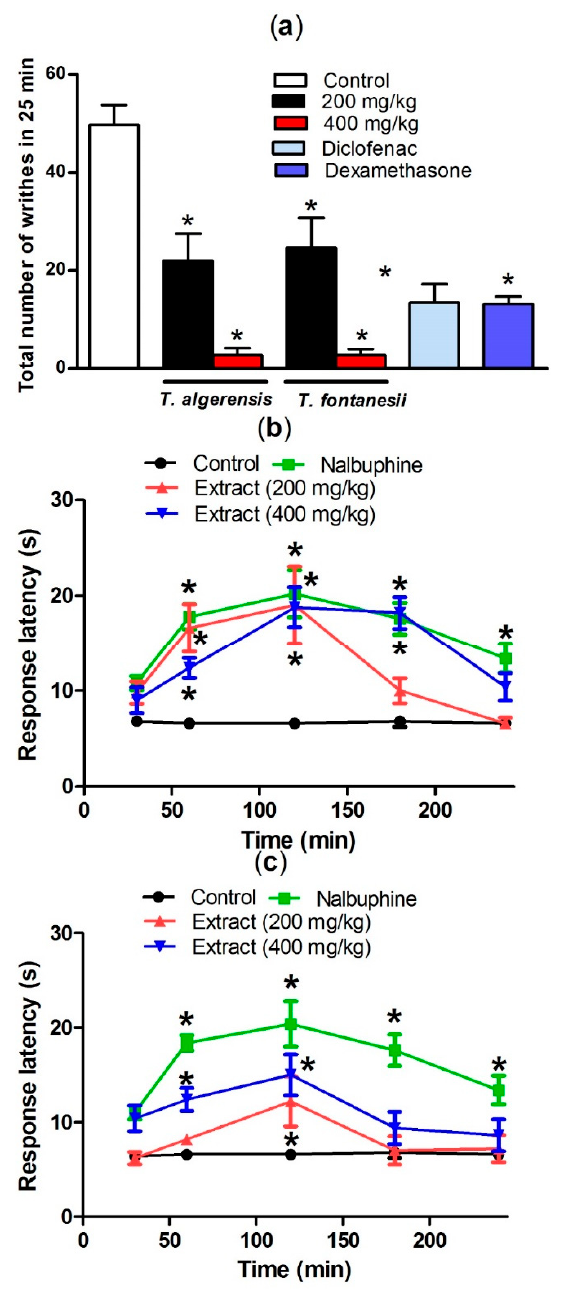
Figure 5. E ff ect of T. algeriensis or T. fontanesii (p.o., 200 and 400 mg / kg), diclofenac (p.o., 20 mg / kg) or dexamethasone- (p.o., 2 mg / kg) on acetic acid (0.7%, 1 mL / 100 g)-induced writhing in mice ( a ). E ff ect Figure 5. Effect of T. algeriensis or T. fontanesii (p.o., 200 and 400 mg/kg), diclofenac (p.o., 20 mg/kg) or of T. algeriensis on hot plate response latency ( b ). E ff ect of T. fontanesii on hot plate response latency dexamethasone- (p.o., 2 mg/kg) on acetic acid (0.7%, 1 mL/100 g)-induced writhing in mice ( a ). Effect ( c ). Response latency in (s) was measured 1–4 h after the di ff erent extracts (200 and 400 mg / kg, p.o.), of T. algeriensis on hot plate response latency ( b ). Effect of T. fontanesii on hot plate response latency vehicle or nalbuphine (p.o., 10 mg / kg). Data is presented as mean ± S.E.M ( n = 5–8). * p < 0.05 vs. ( c ). Response latency in (s) was measured 1–4 h after the different extracts (200 and 400 mg/kg, p.o.), control values by one-way ANOVA followed by Tukey post hoc vehicle or nalbuphine (p.o., 10 mg/kg). Data is presented as mean ± S.E.M ( n = 5–8). * p < 0.05 vs. control values by one-way ANOVA followed by Tukey post hoc test.